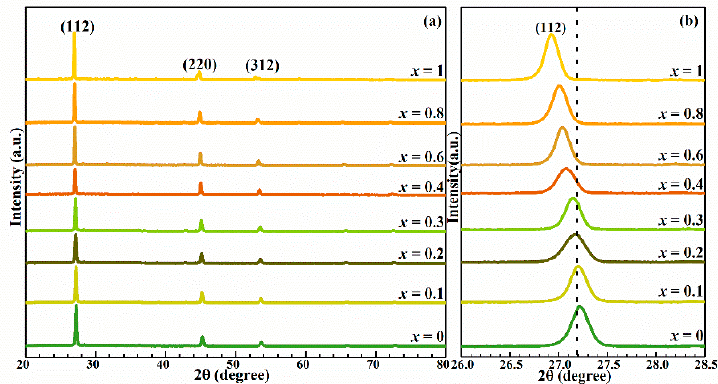
Figure 1. ( a ) XRD spectra of Cu 2 Mn x Zn 1 − x Sn(S,Se) 4 (0 ≤ x ≤ 1) thin films. ( b ) Enlarged view of the corresponding (112) diffraction peaks of the Cu 2 Mn x Zn 1 − x Sn(S,Se) 4 (0 ≤ x ≤ 1) thin films.